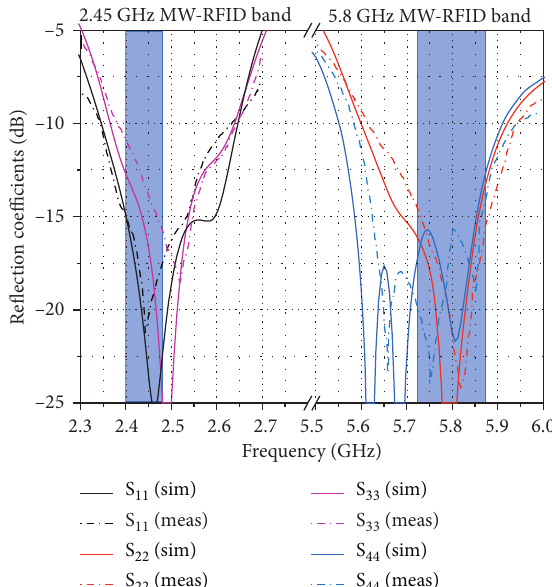
Figure 12: Simulated and measured reflection coefficients.